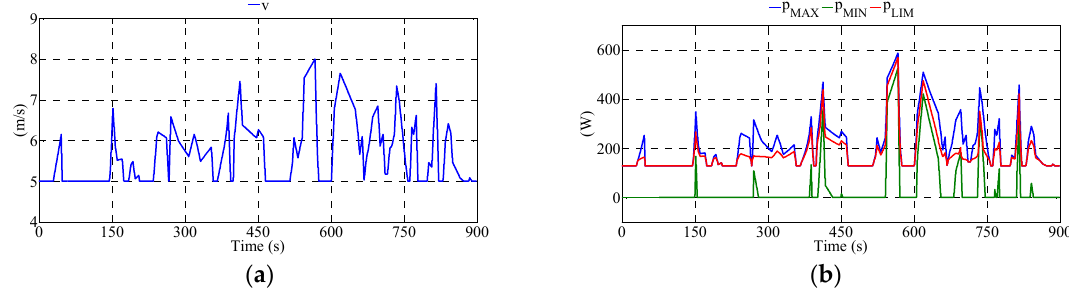
Figure 11. Profile of: ( a ) the selected v ; ( b ) MAX p , MIN p and LIM p .